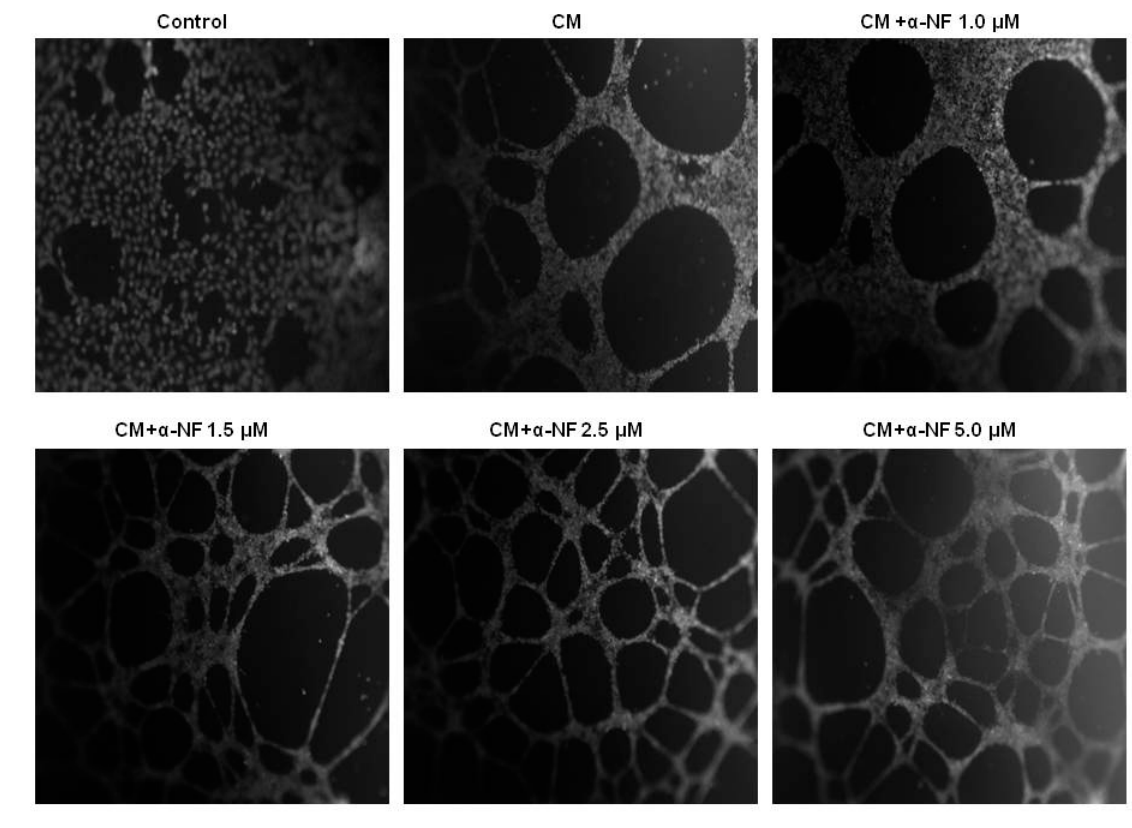
Figure 3. Effects of α-naphthoflavone (α-NF) on vascular tube formation in endothelial cells activated with α-NF-treated conditioned medium (CM). After full differentiation,